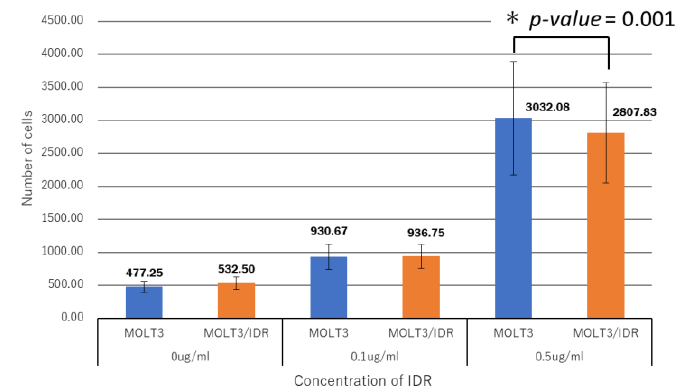
Figure 4. Analysis of idarubicin (IDR) permeability at concentrations of 0, 0.1, and 0.5 μg /mL IDR in